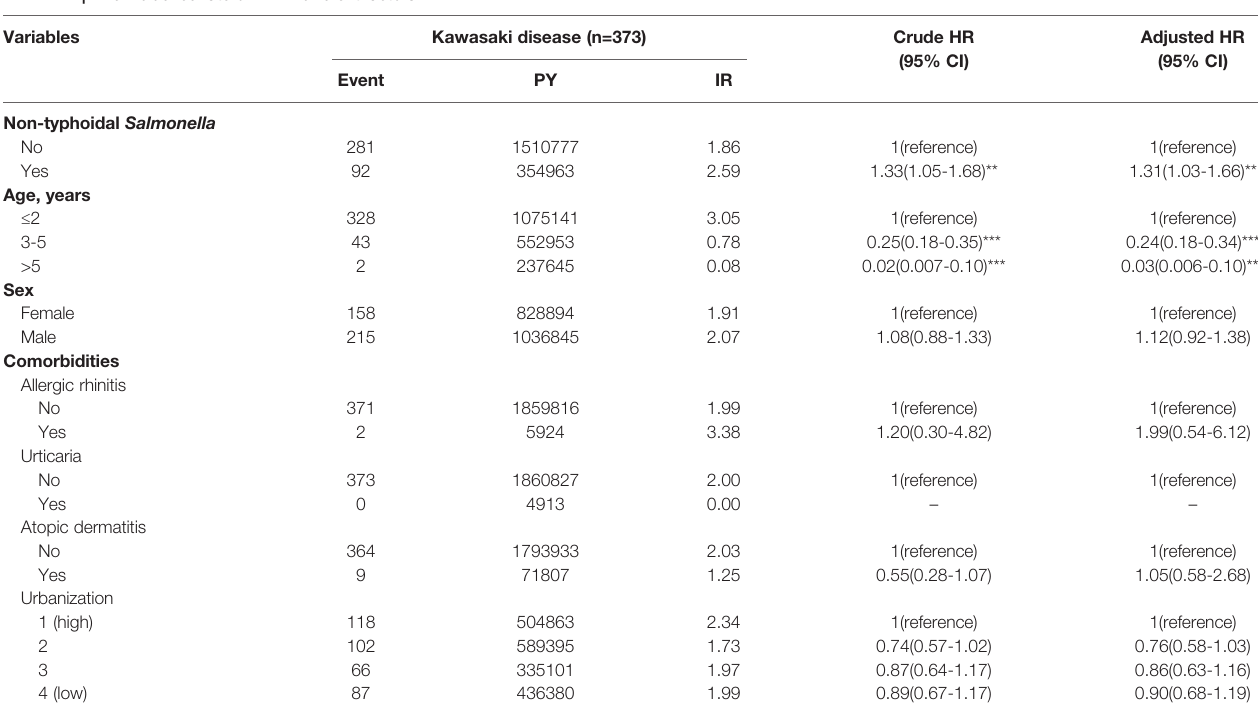
TABLE 2 | The incidence rate of KD in different